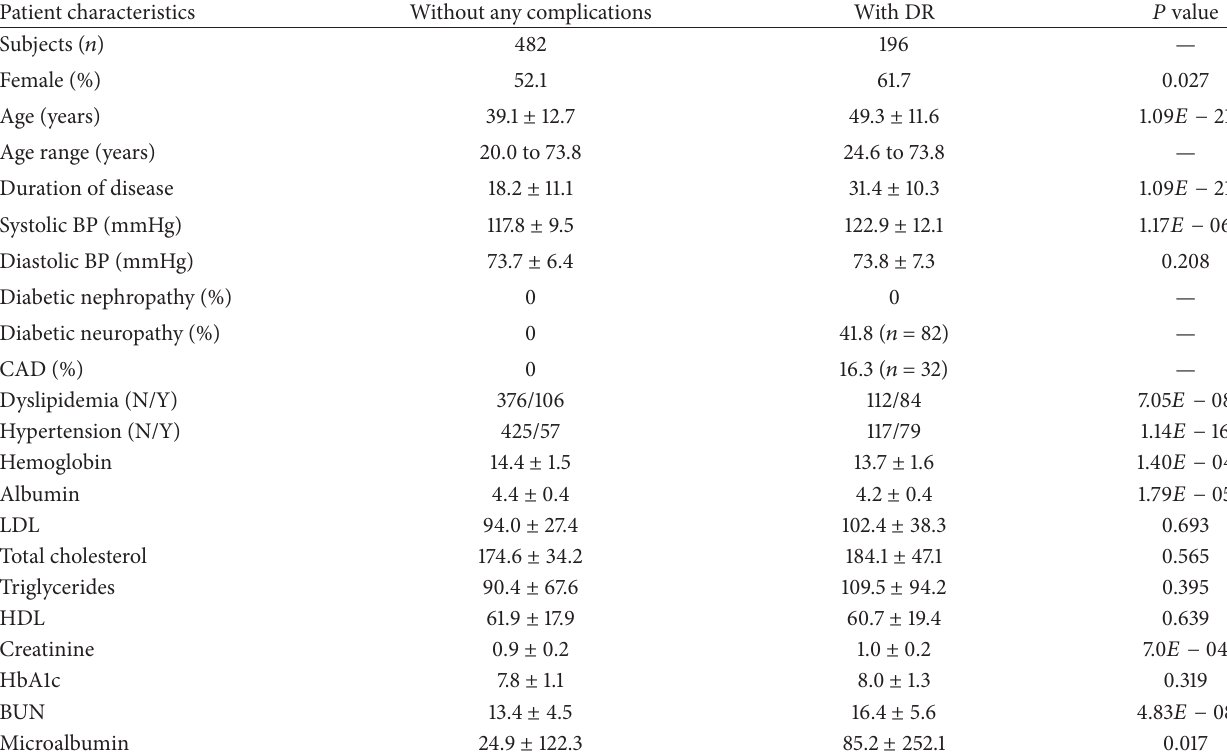
Table 1: Baseline characteristics of T1D subjects without complications and with diabetic retinopathy (DR). Patient